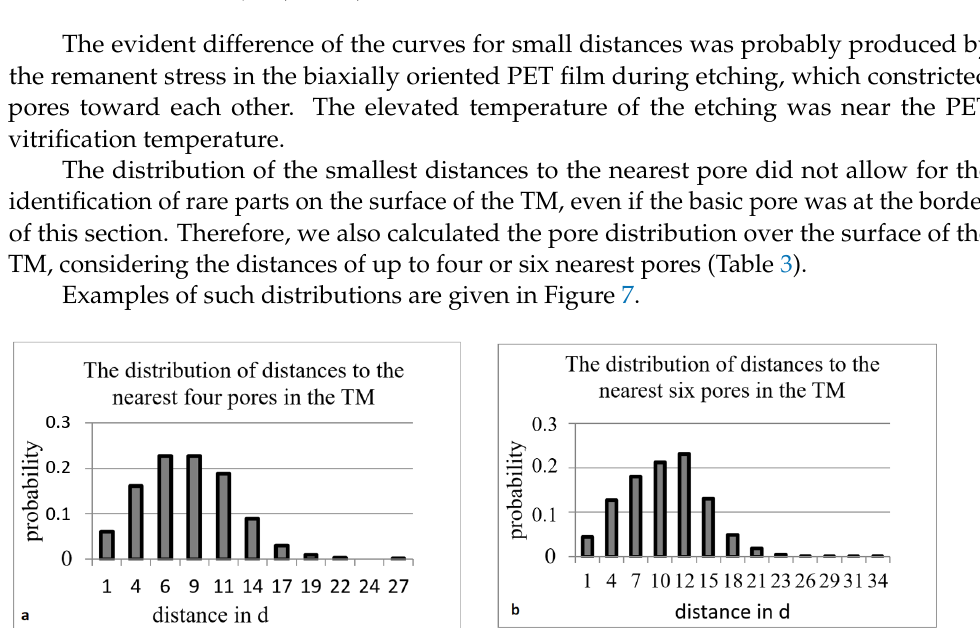
Figure 6. Theoretical (Formula (2)) and experimental distance distribution functions for TM with n = 10 6 cm − 2 and d = 4 μ m (Table 2).